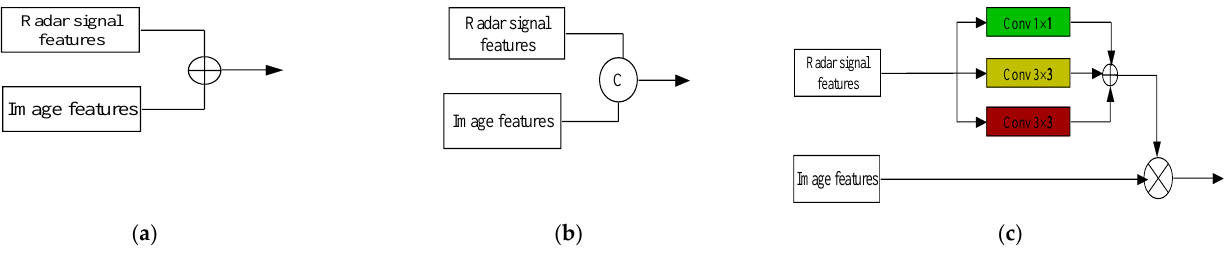
Figure 10. Fusion operation. ( a ) Element-wise addition. ( b ) Concatenation. ( c ) Spatial attention method [58].